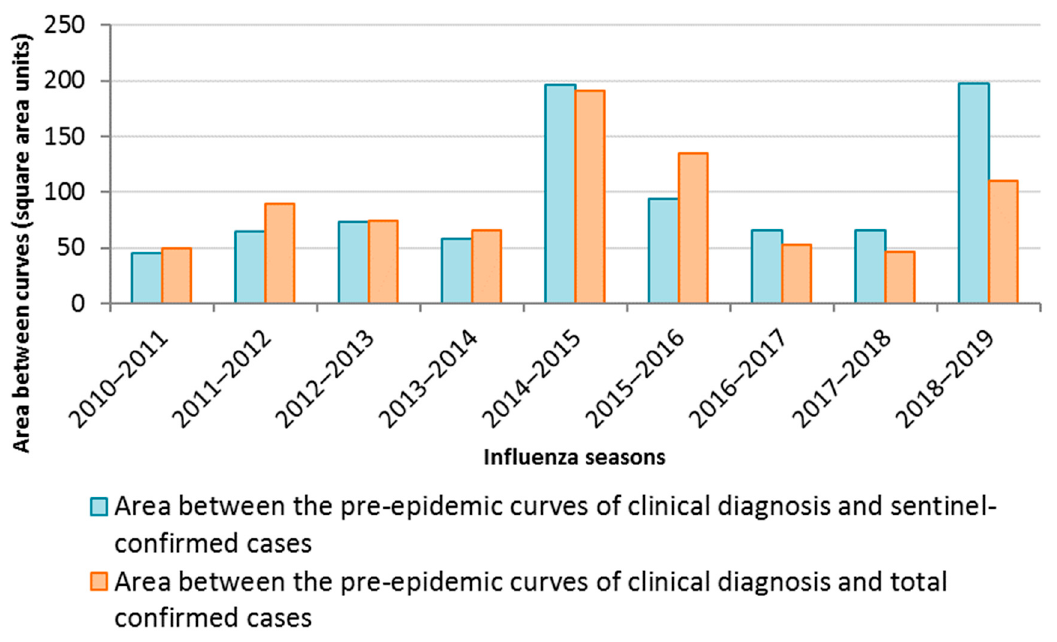
Figure 2. Areas between the pre-epidemic curves of clinical diagnostic, sentinel-confirmed and total confirmed case rates. Start of the epidemic calculated from the rates of sentinel-confirmed cases.